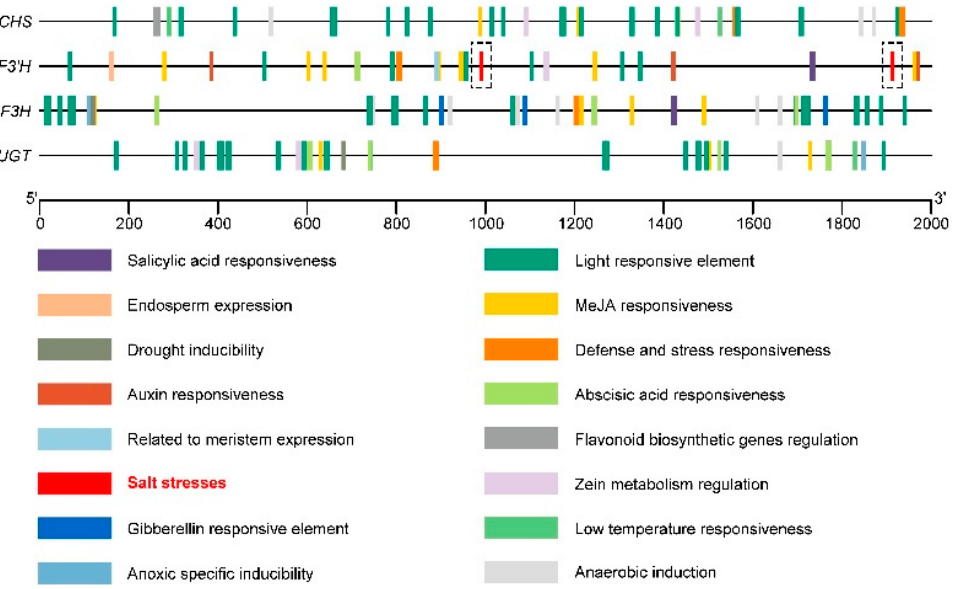
Figure 9. The cis-acting element of the promoter sequence (upstream 2000 bp) of the key genes CHS , F3 ′ H , F3H , and UGT in the Tartary buckwheat flavonoid synthesis pathway. F3 (cid:48) H , F3H , and UGT in the Tartary buckwheat flavonoid synthesis